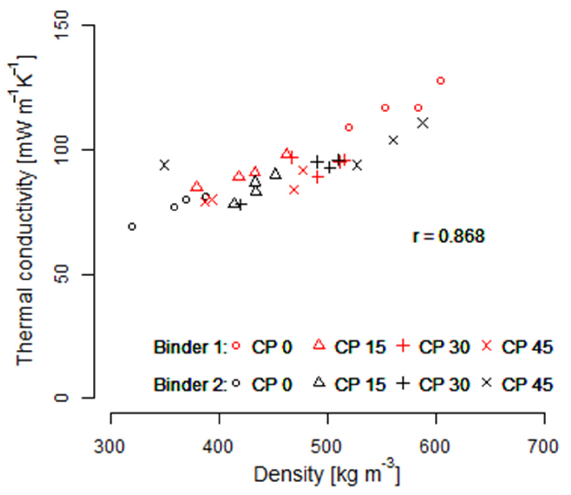
Figure 11. Scatterplot of sample density against thermal conductivity values for both Binders at different ratios of cup plant biomass and EPS [ n = 4, r = 0.868, p = 1.245 × 10 − 10 ].